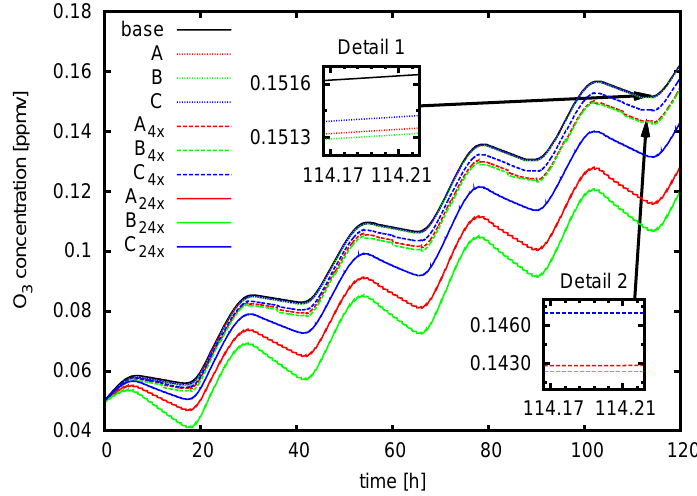
Fig. 7. The temporal evolution of the gas-phase O 3 concentration is shown for a base scenario with no heterogeneous chemistry, for the model scenarios A, B, C, and the corresponding low and high emission scenarios A 4x , B 4x , C 4x and A 24x , B 24x , C 24x , respectively. Detail 1 shows an enlarged view of the results of the base scenario and model scenarios A, B, and C. Detail 2 shows an enlarged view of the results for the low emissions scenarios A 4x , B 4x , C 4x . Input parameters for the A, B, and C-scenarios are given in Table 1.